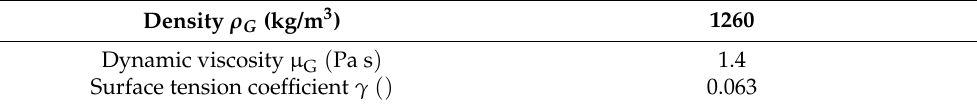
Table 4. Transport properties of the glycerol.